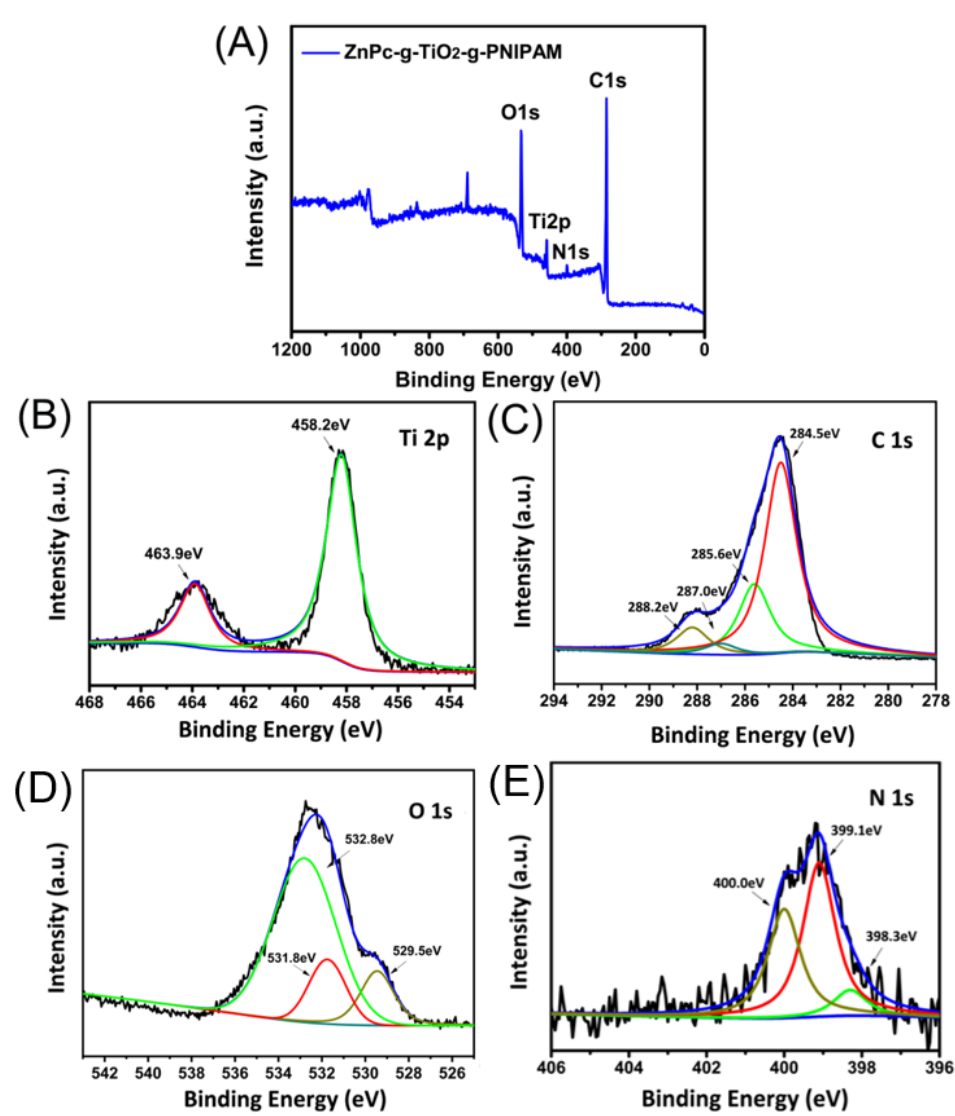
Figure 2. XPS spectra of ZnPc- g -TiO 2 - g -PNIPAM ( A ); Ti 2p ( B ) and C 1s ( C ); O 1s ( D ); N 1s ( E ) spectra of ZnPc- g -TiO 2 - g -PNIPAM.